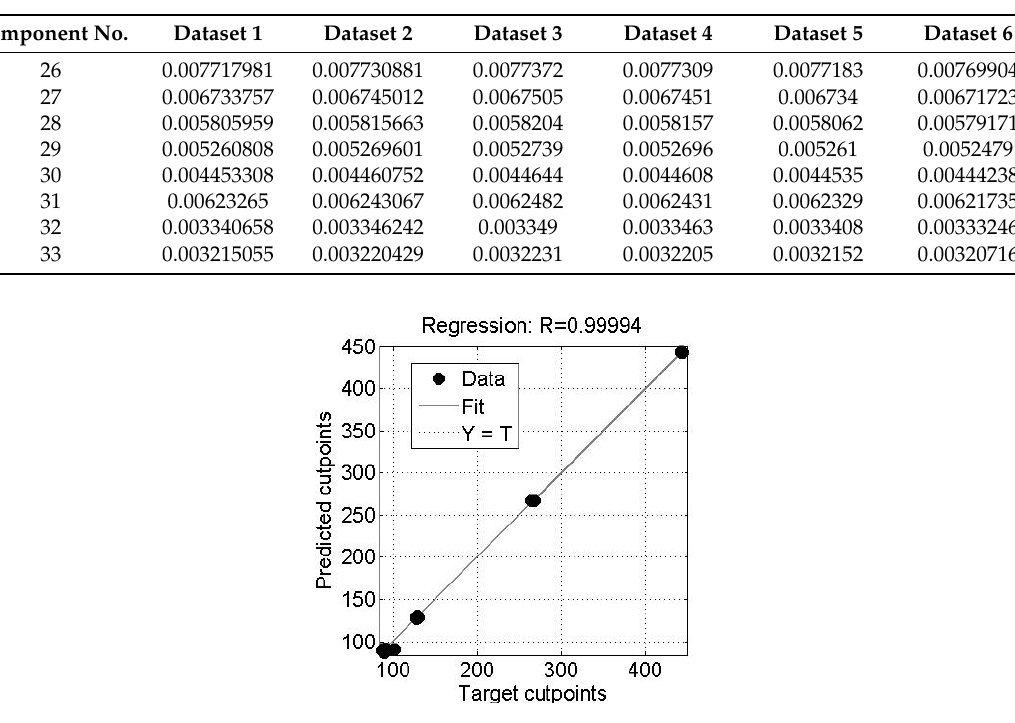
Figure 5. ANN-based prediction of cut points.